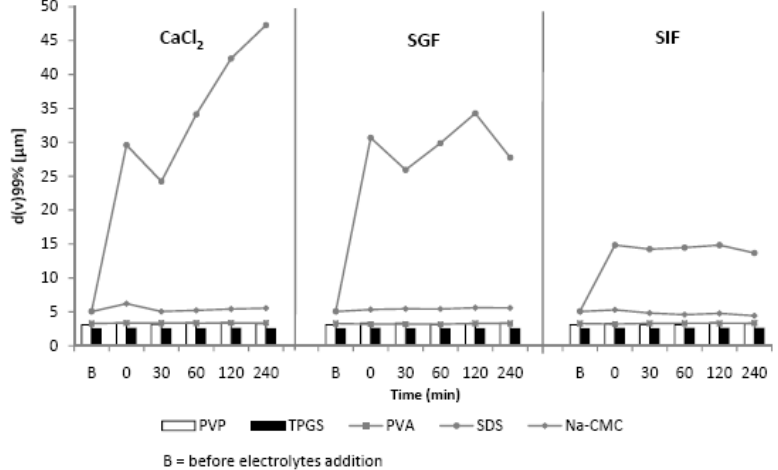
Figure 2. Diameter D 99 of the five different curcumin nanosuspensions after addition of CaCl 2 (left), simulated gastric fluid (SGF, middle) and simulated intestinal fluid (SIF, right). Measurements were performed as a function of time by laser diffractometry (LD). PVP: polyvinyl pyrrolidone; TPGS: D - α -tocopheryl polyethylene glycol 1000 succinate; PVA: polyvinyl alcohol, SDS: sodium dodecyl sulfate; Na-CMC: sodium